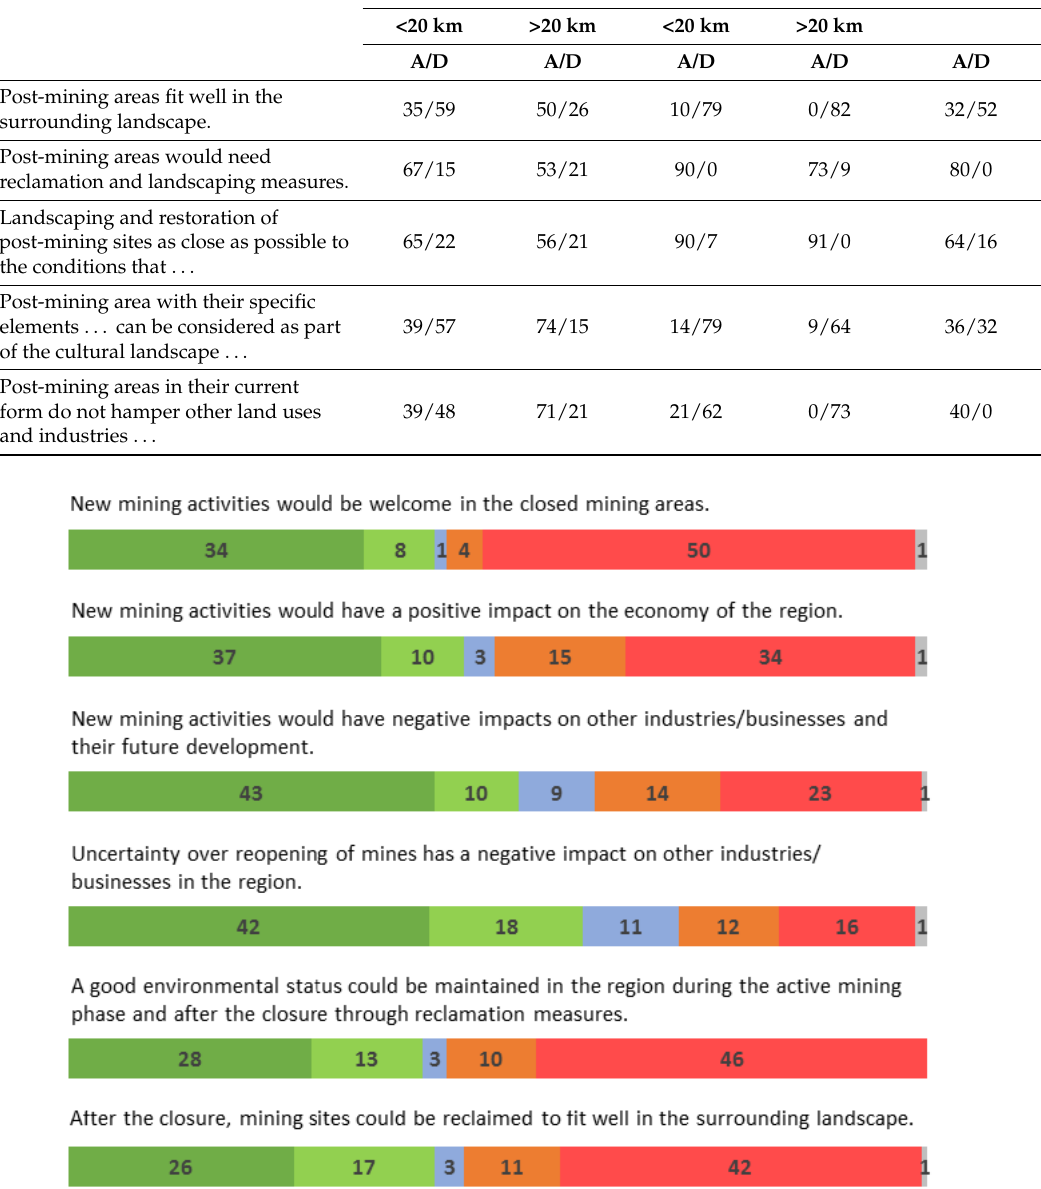
Table 3. Respondents’ opinions on statements related to post-mining landscapes in the Hannukainen/ Rautuvaara region in different stakeholder groups. Proportions for agreement (A) and disagreement (D) are calculated using the total number of respondents within each category: local residents <20 km distance (n = 46) and >20 km distance (n = 34), vacation home owners <20 km distance (n = 29) and >20 km distance (n = 11), and visitors (n = 25). Local Resident (%) V. Home Owner (%)